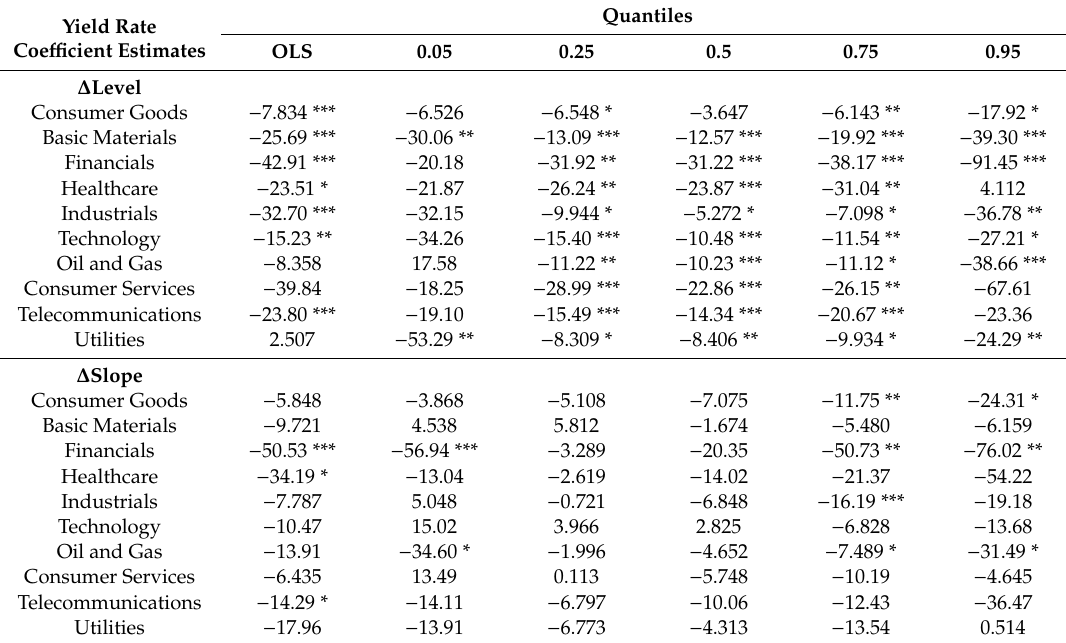
Table 4. Quantile regression estimated yield rate coe ffi cients of the U.S. industrial